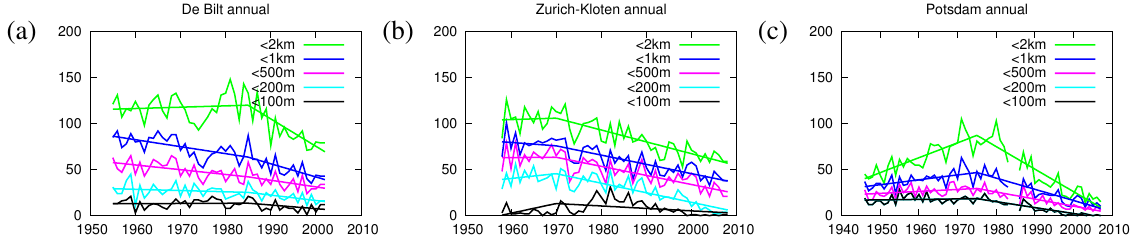
Table 1. Fraction of the 329 stations with positive/negative trends in days with low visibility that are significant at the p -values in the first column.